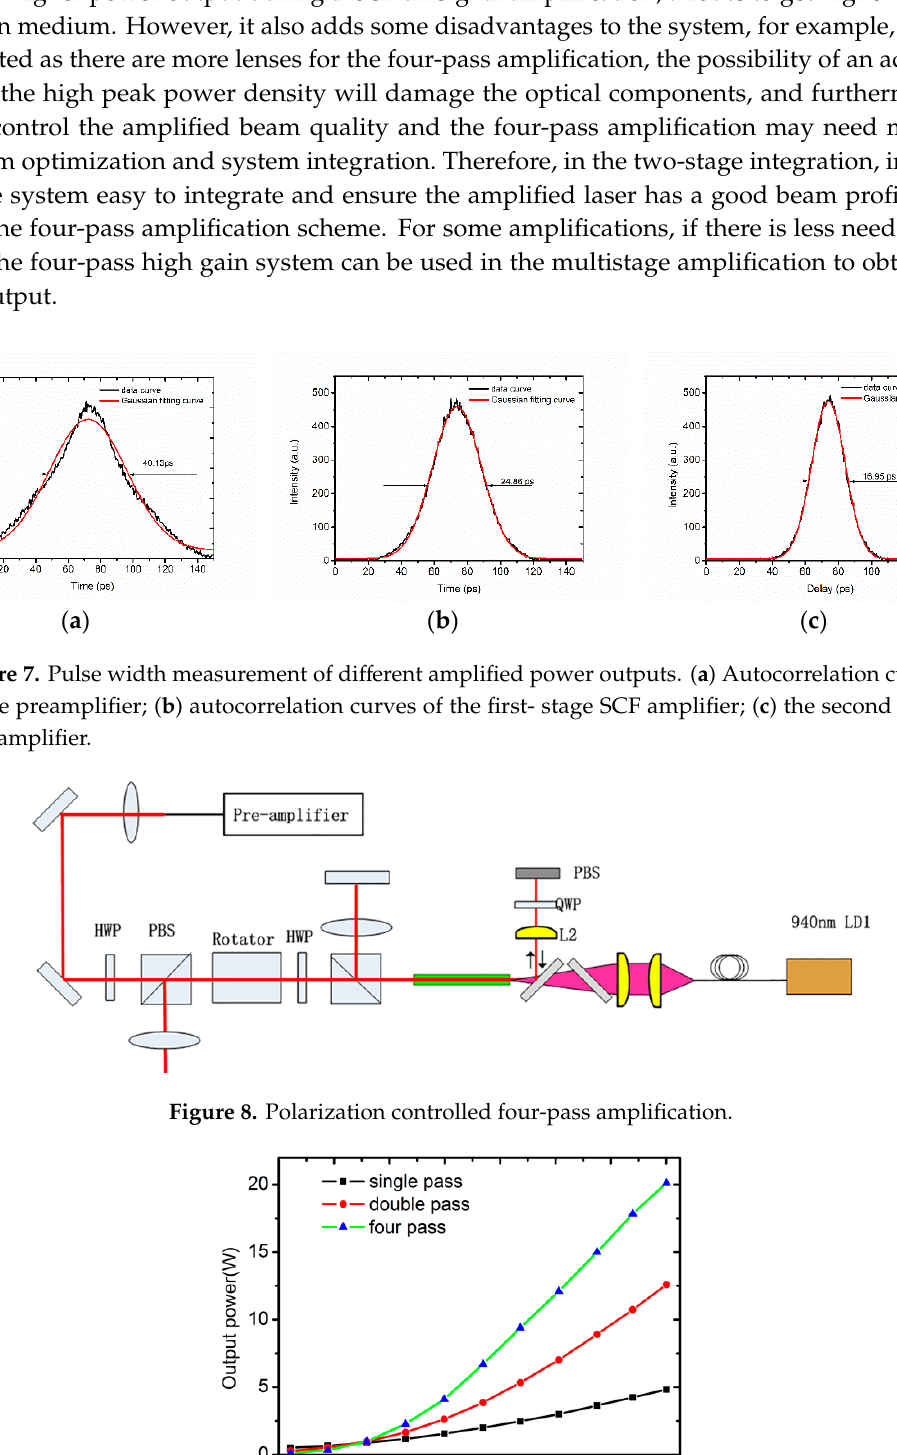
Figure 7. Pulse width measurement of different amplified power outputs. ( a ) Autocorrelation curves of the preamplifier; ( b ) autocorrelation curves of the first ‐ stage SCF amplifier; ( c ) the second stage SCF amplifier.